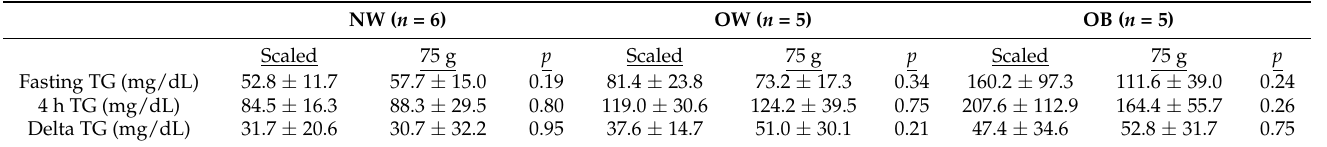
Table 2. Postprandial Triglyceride Responses to the Scaled and 75 g High-fat Meals within BMI